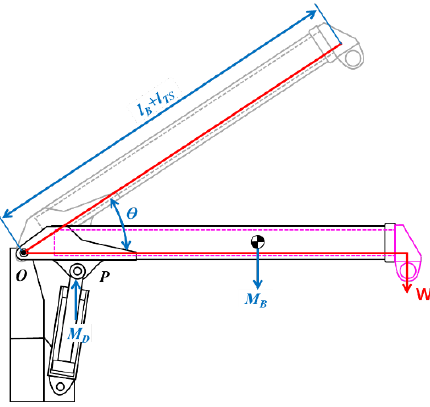
Figure 2. Free-body diagram for the cargo crane analysis.